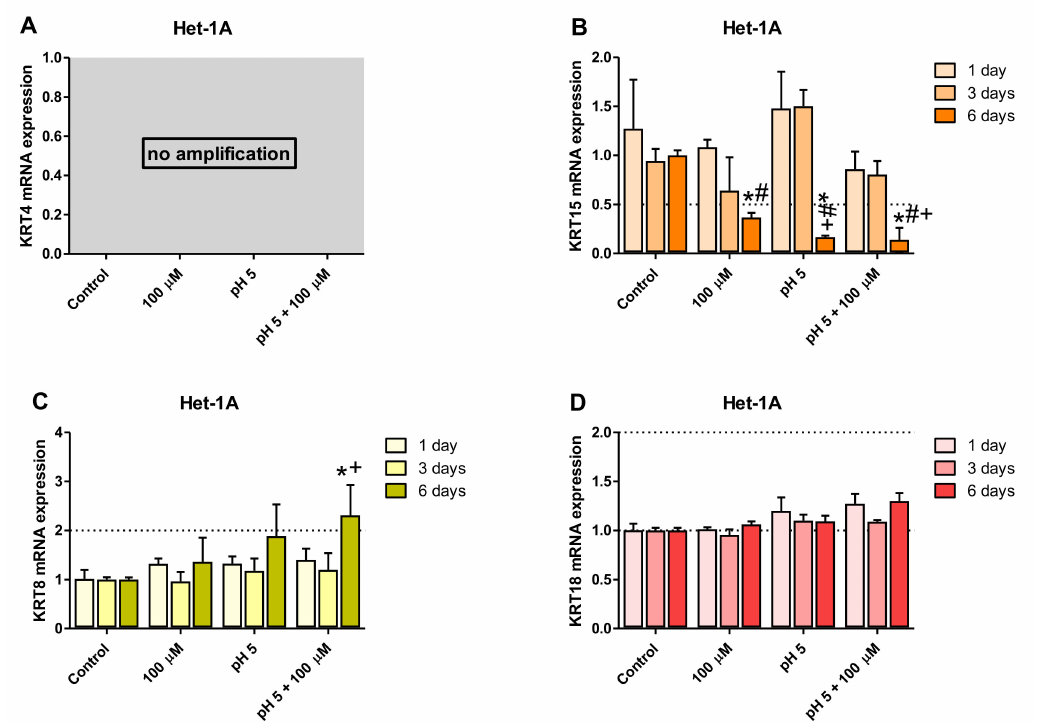
Figure 2. The e ff ect of treatment with bile mixture (BM), acidified medium alone or acidic BM for one, three and six consecutive days on KRT4 , 15 , 8 and 18 mRNA expression in Het-1A cell line. Het-1A cell line underwent 30 min of daily incubation with BM at concentration of 100 µ M, acidified medium to pH 5.0 alone or BM (100 µ M) in acidified medium (pH 5.0) for one, three or six consecutive days and expression of KRT4 , KRT15 , KRT8 and KRT18 mRNA was analyzed by real-time PCR ( A – D ). PCR reaction was performed in duplicates and quantified using ACTB / GAPDH as reference genes. Data from three independent experiments are shown as the mean ± SEM. An asterisk (*) indicates a significant change as compared with untreated control cells ( p < 0.05). Significant change ( p < 0.05) in gene expression as compared with one day exposure to respective treatment regime is indicated by a hash (#). A cross ( + ) indicates a significant change as compared with cells after three days of treatment for respective treatment regime ( p <